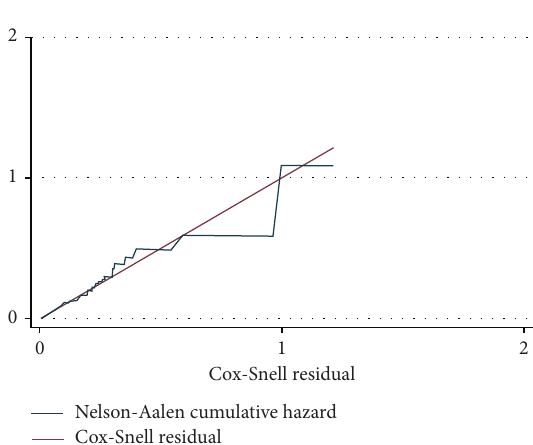
Figure 2: Cox–Snell residuals for Weibull PH models of